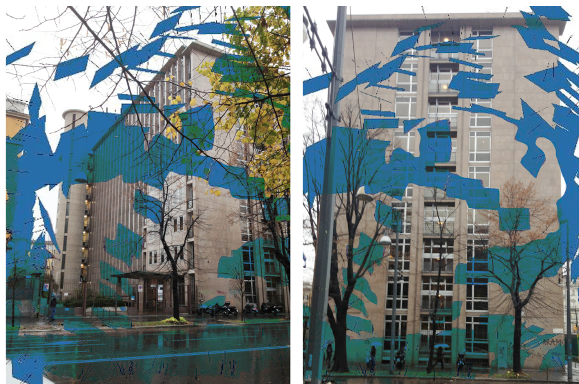
Figure 8. Building for offices (1949) in Milan, Italy (architect P. Lingeri). Image position around the building. Course of Architectural Drawing, Milan Polytechnic (De Masi, A.)